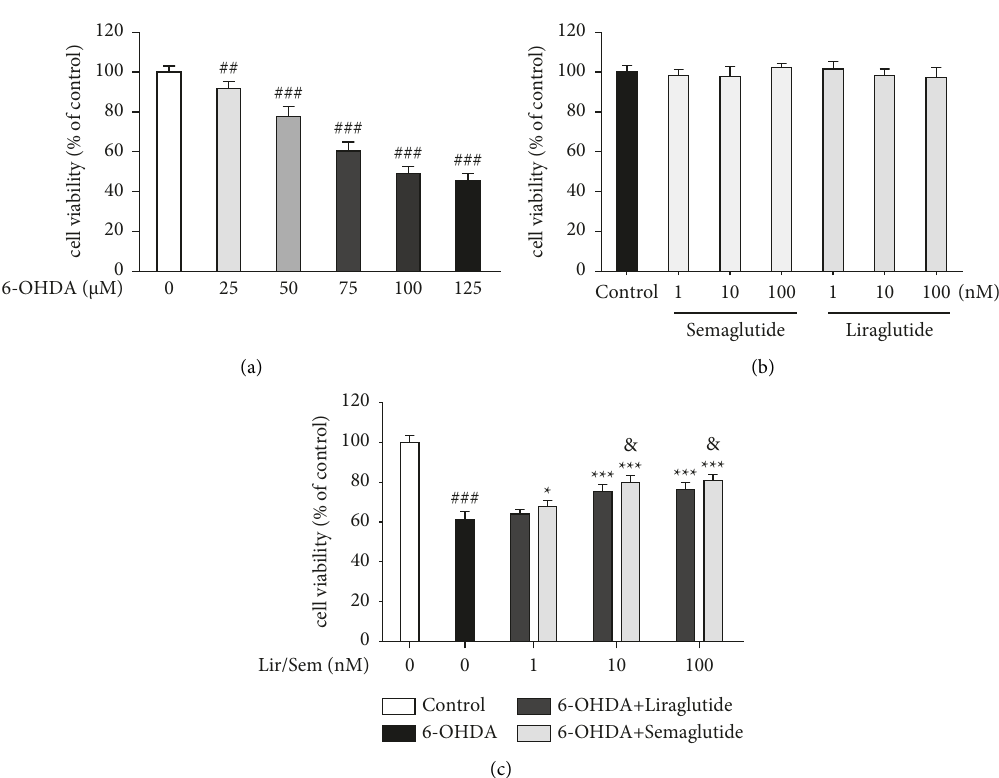
Figure 1: (a) With the increase of 6-OHDA concentration, the survival rate of SH-SY5Y cells decreased gradually. And the survival rate of SH-SY5Y cells was 50% of the control group when the 6-OHDA concentration was 75 μ mol/L. ### P Different concentrations of semaglutide and liraglutide had no significant effect on the survival rate of SH-SY5Y cells compared with the control group. (c) Semaglutide and liraglutide reverse cytotoxicity in 6-OHDA-treated SH-SY5Y cells, whereas semaglutide is more ef- fective. Cells were treated with 6-OHDA (75 μ M) for 24 (h). ### P treatment. &